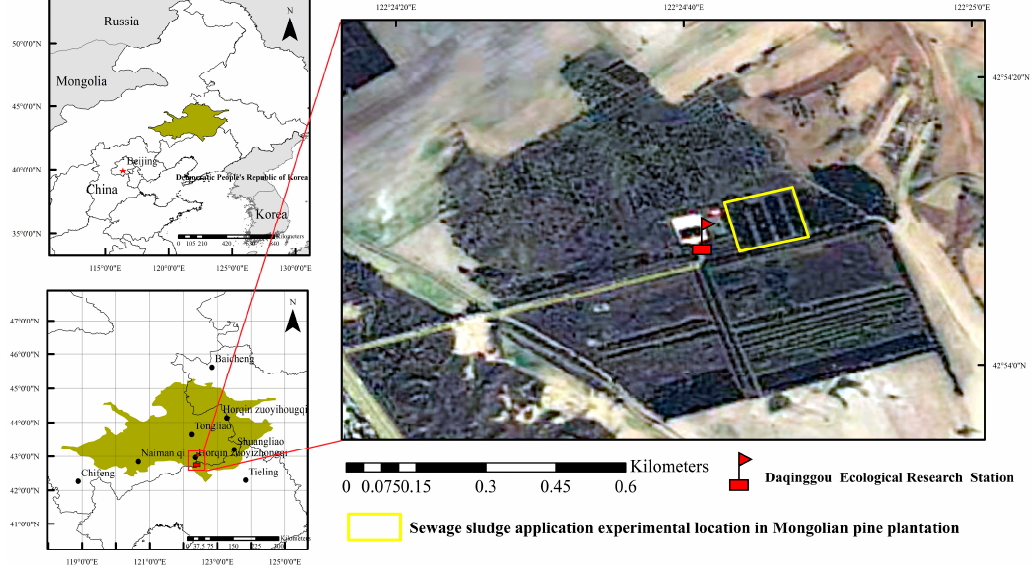
Figure 1. Study area (Daqinggou Ecological Research Station, Ganqika Town, Tongliao City, Inner Mongolia, China; southeastern edge of Horqin Sandy Land).